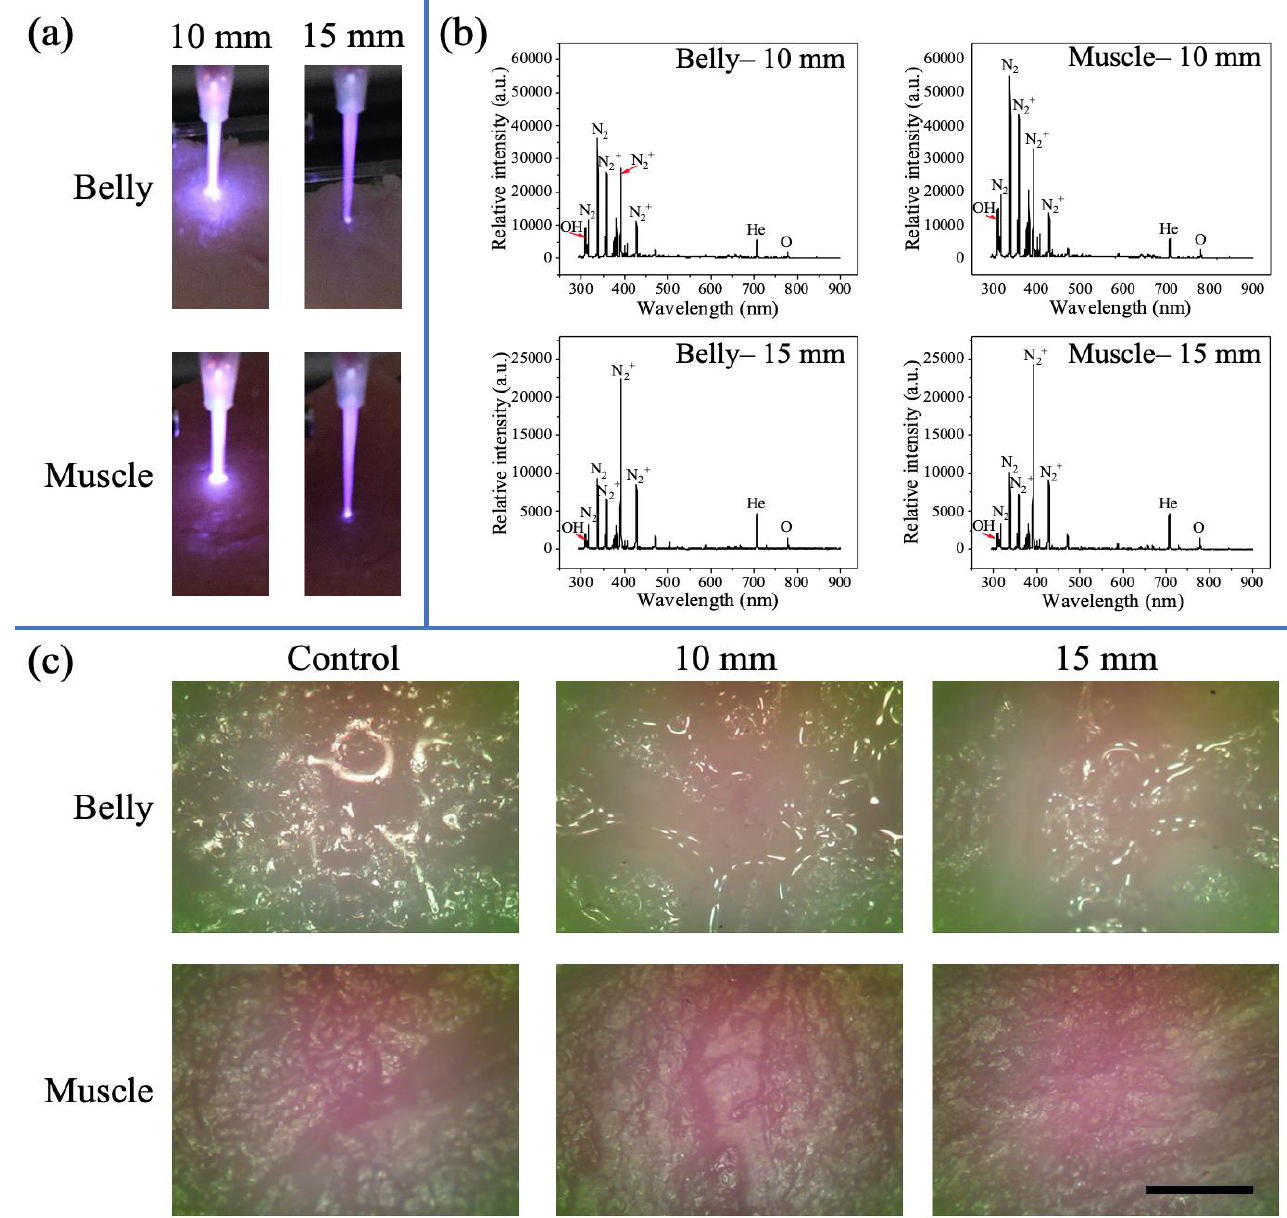
Figure 5. ( a ) Images of tiny plasma jet interacting with pork belly and muscle at 10 mm and 15 mm distance. ( b ) The effect of interacting processes between jets and pork (belly and muscle) on optical emission spectra of tiny plasma jets. ( c ) The surface images of pork (belly and muscle) after jet-pork interactions for control (0 min), 10 mm (2 min), and 15 mm (2 min). Tissue surface measurements were made using a BW500 Digital Microscope to examine the surface of each sample. Scale bar: 1 mm.